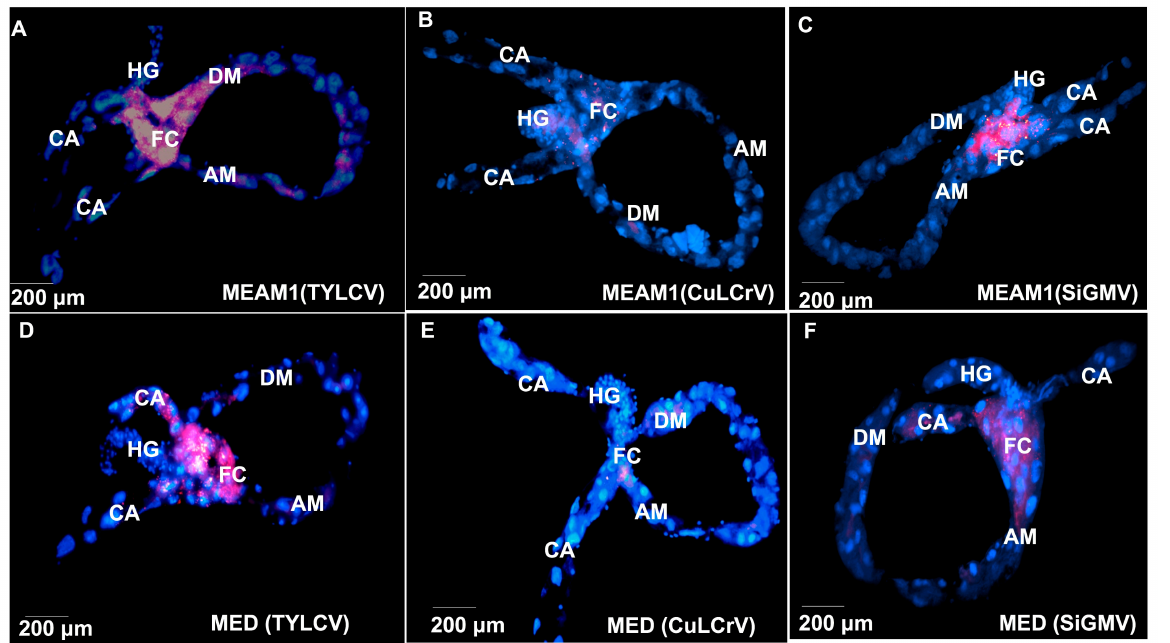
Figure 3. TYLCV, CuLCrV, or SiGMV localization in the midgut dissected from B. tabaci adults (MEAM1 or MED) that fed on TYLCV-infected tomato, CuLCrV-infected squash, or SiGMV-infected prickly sida. FISH signals from Cy3-labeled virus-specific probe (red) and DAPI stained nuclei (blue) as seen from Olympus BX 60 fluorescence microscope at 200 × magnification using Cy3 and DAPI filter cubes. FC: filter chamber; DM: descending midgut; AM: ascending midgut; CA: caeca; and HG: hindgut. Midgut of B. tabaci MEAM1 following ( A ), TYLCV acquisition, ( B ), CuLCrV acquisition and ( C ), SiGMV acquisition. Midgut of B. tabaci MED following ( D ), TYLCV acquisition, ( E ), CuLCrV acquisition, and ( F ), SiGMV acquisition.